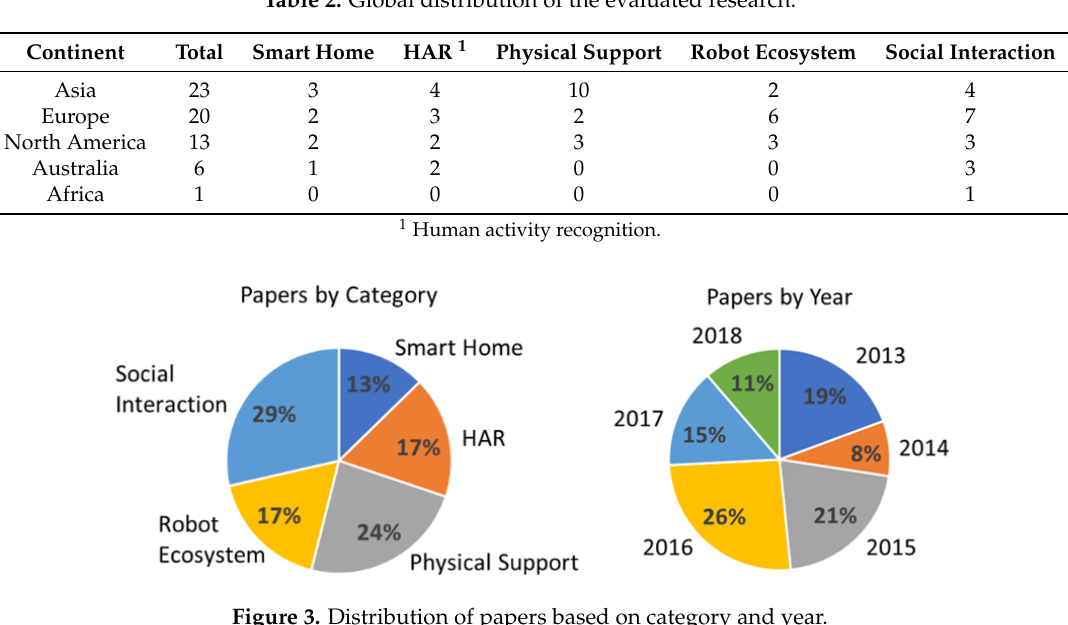
Table 2. Global distribution of the evaluated research.